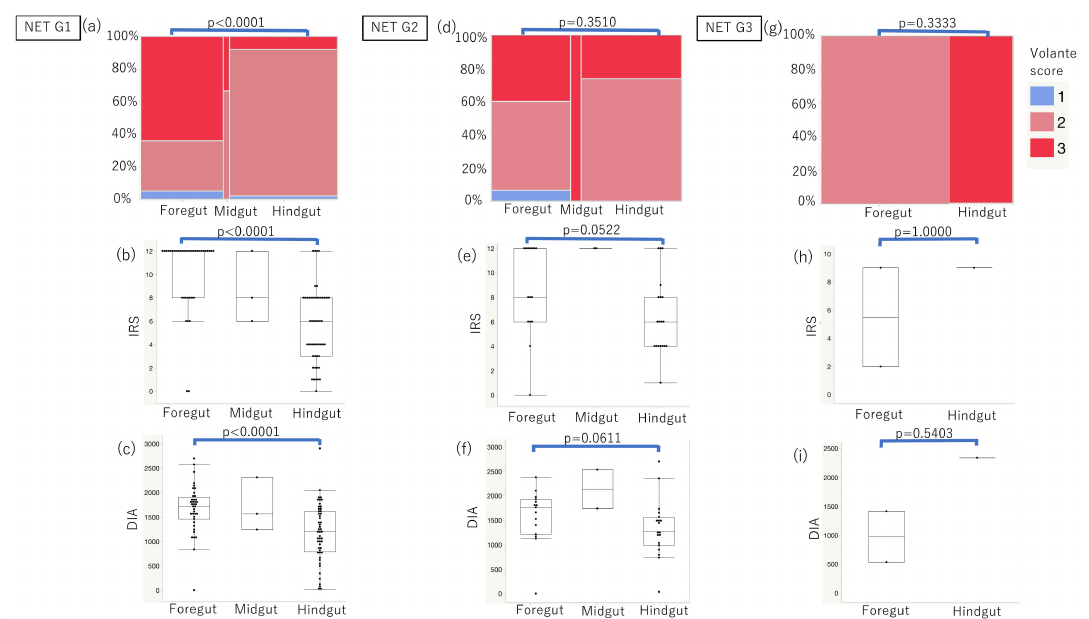
Figure 2. Correlation between SSTR2 immunoreactivity and embryonal sites of origin in NET G1, G2, and G3, respectively. ( a – c ) In GI-NETs G1, foregut NETs demonstrated significantly higher immunore- activity than hindgut NETs according to all scoring systems ( p < 0.0001). ( d – f ) In GI-NETs G2, foregut NETs showed close to significantly higher immunoreactivity than hindgut NETs using IRSs and DIA ( p = 0.0522, p = 0.0611, respectively). ( g – i ) In GI-NETs G3, there were no significant differences of SSTR2 immunoreactivity evaluated by all scoring systems between foregut and hindgut GI-NETs.